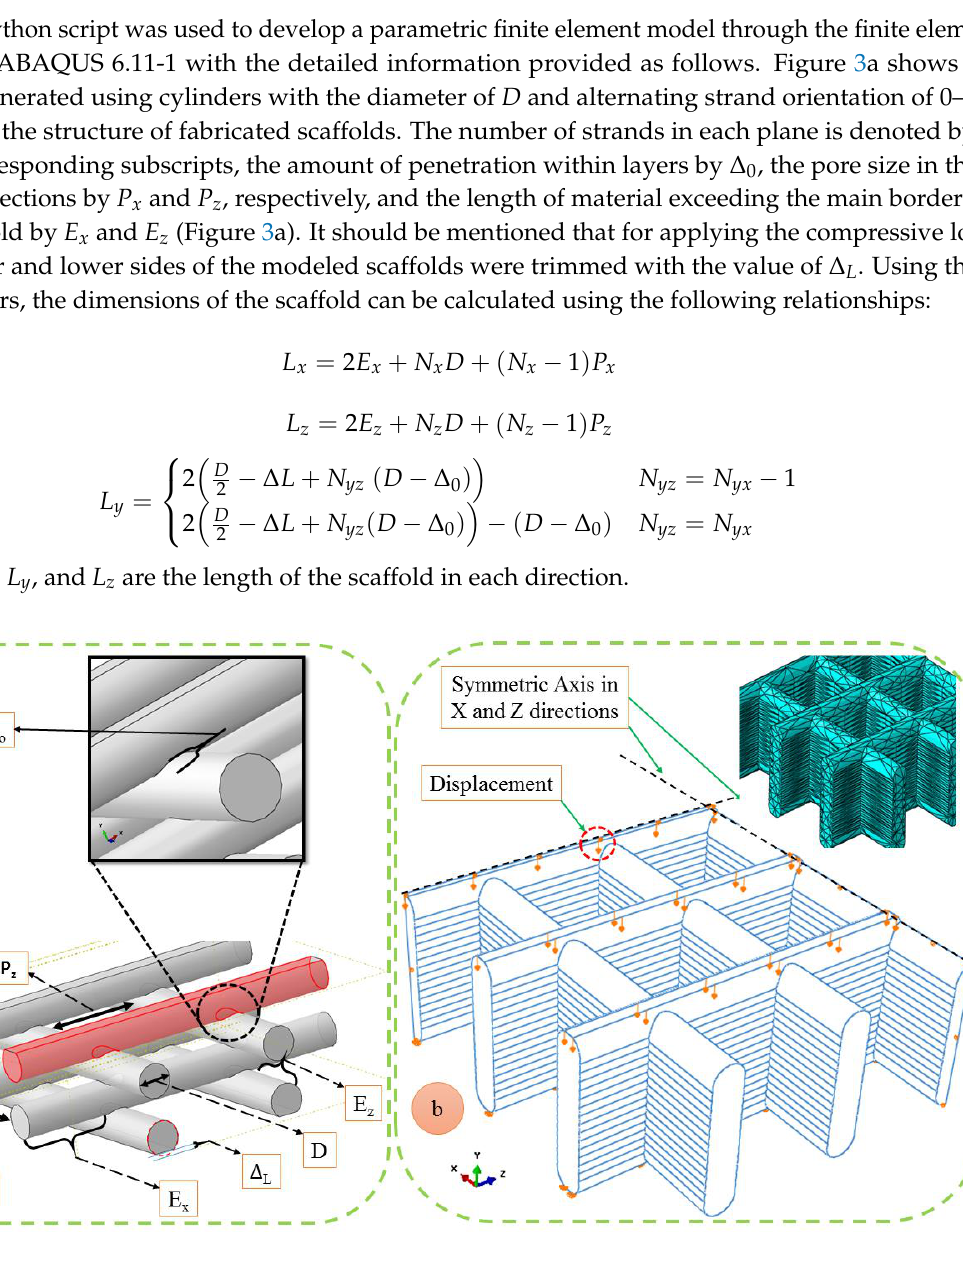
Figure 3. ( a ) Applied parameters in finite element model including the amount of penetration within layers ( Δ 0 ), pore size in the X and Z directions ( P x and P z ), E x and E z as the extra material exceeding the main borders of the scaffold. ∆ L is also the amount of trimmed value of the upper and lower sides of the modeled scaffolds for applying the compressive load and D is the strand diameter and ( b ) applied boundary conditions and meshed